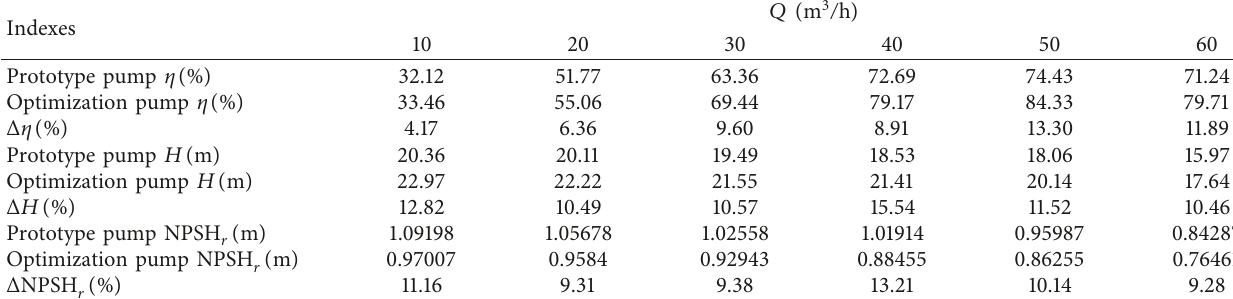
Table 6: Experimental results of prototype pump and optimization